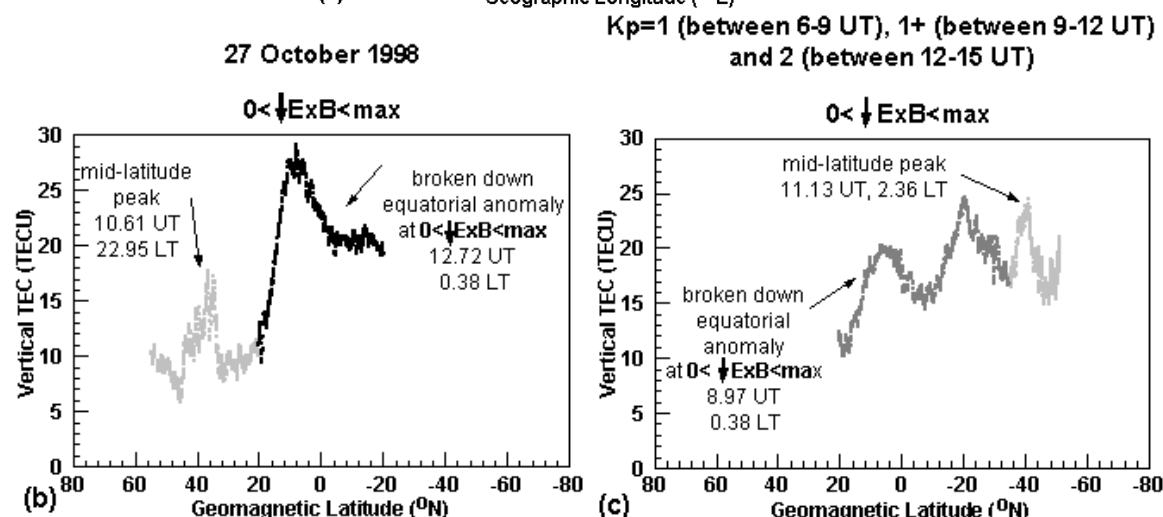
Fig. 6. (a) The ground tracks of the TOPEX passes are plotted with the magnetic field lines to show the field-aligned TOPEX passes. (b)–(c) The field-aligned TOPEX TEC cross sections depict the broken down equatorial anomaly at less than maximum downward drift and the mid-latitude night-time TEC